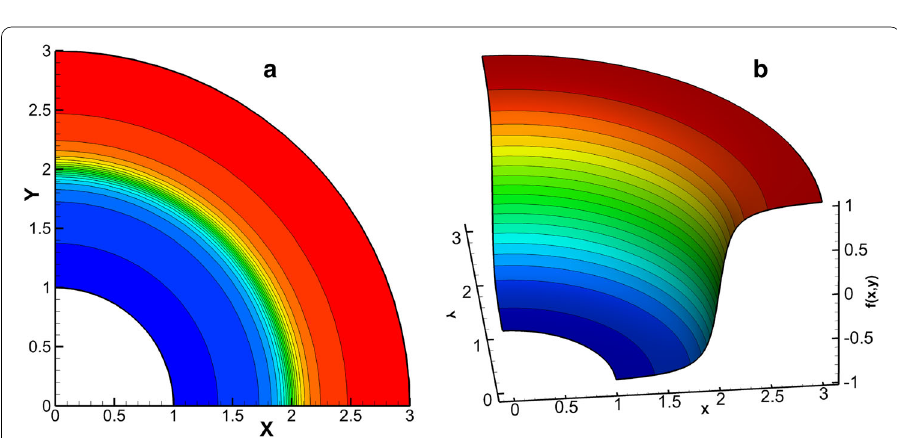
Fig. 17 Domain and function contours ( a ) and 3D representation of the considered function ( b